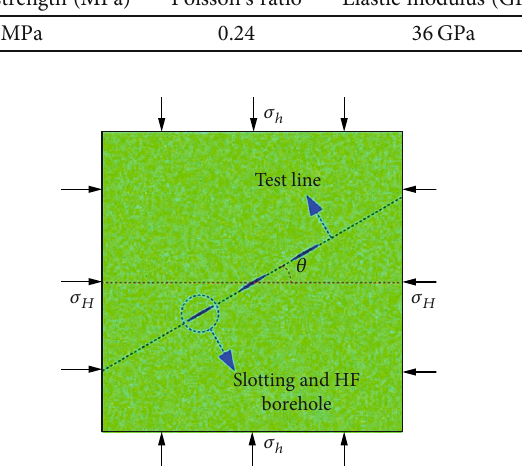
Figure 6: Model design in the numerical analysis: θ represents the slotting deviation